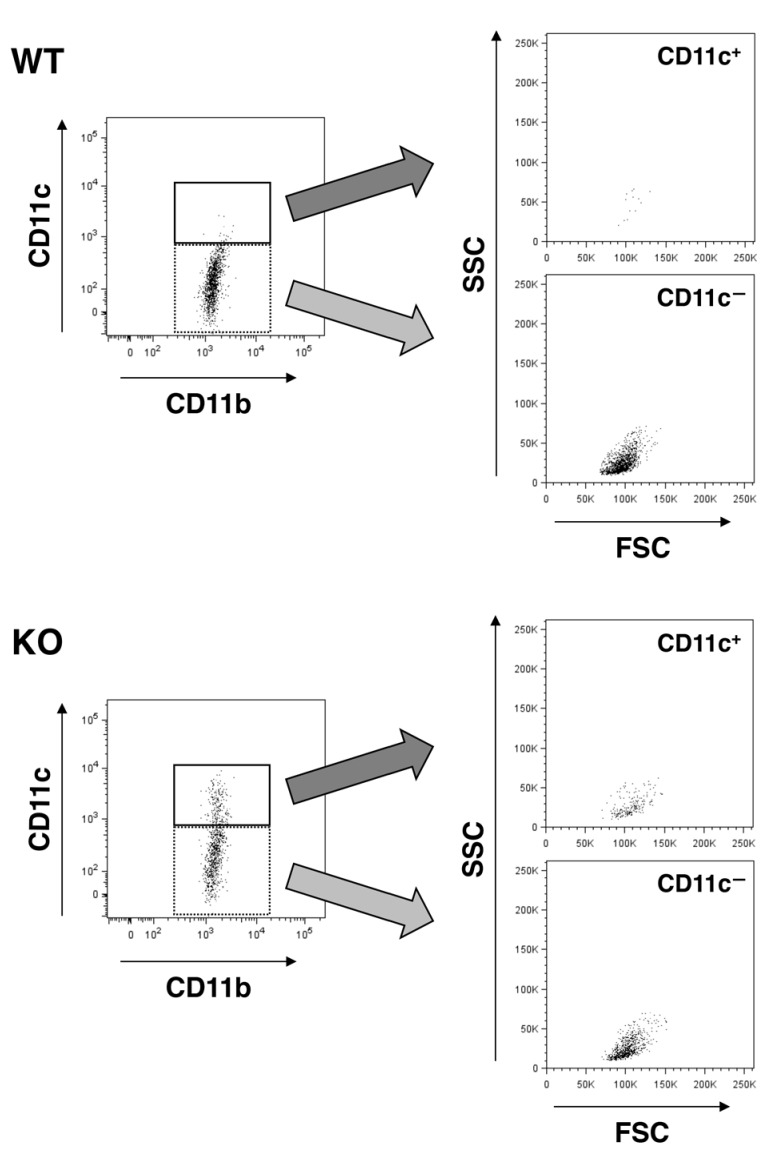
Forward (FSC) and side (SSC) scatter distribution of CD11c+microglia.FSC/SSC distribution of WT (upper panels) and SIRPαKO (lower panels) microglia were analysed. CD11c+ and CD11c— microglia in the left panels (events in the solid and dotted rectangles, respectively) are presented on the FSC/SSC plots in the right panels. Scatter plots in the left panels are identical to those shown in Figure 3B. All data used in Figure 3B were analysed in the same way, and representative results are shown.